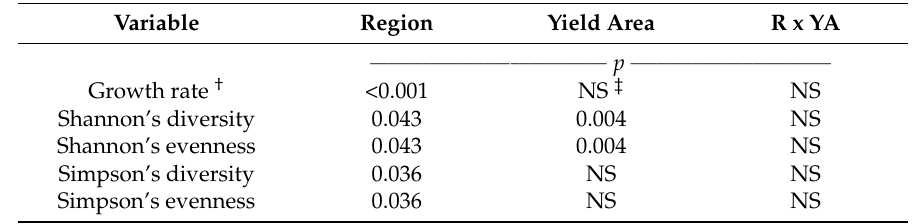
† Units are absorbance day − 1 . ‡ Effects and interactions that are not significant at the 0.05 level are represented by NS (i.e., p > 0.05).